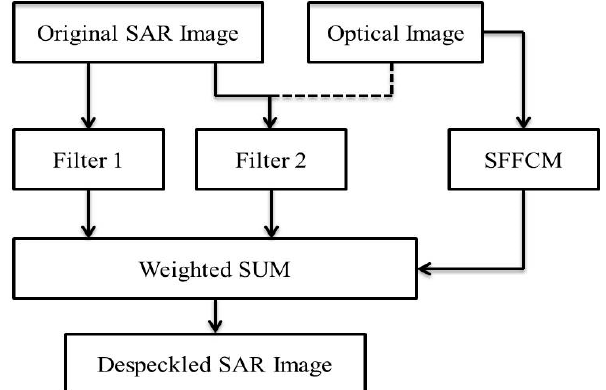
Figure 3. Block diagram of the proposed despeckling method.